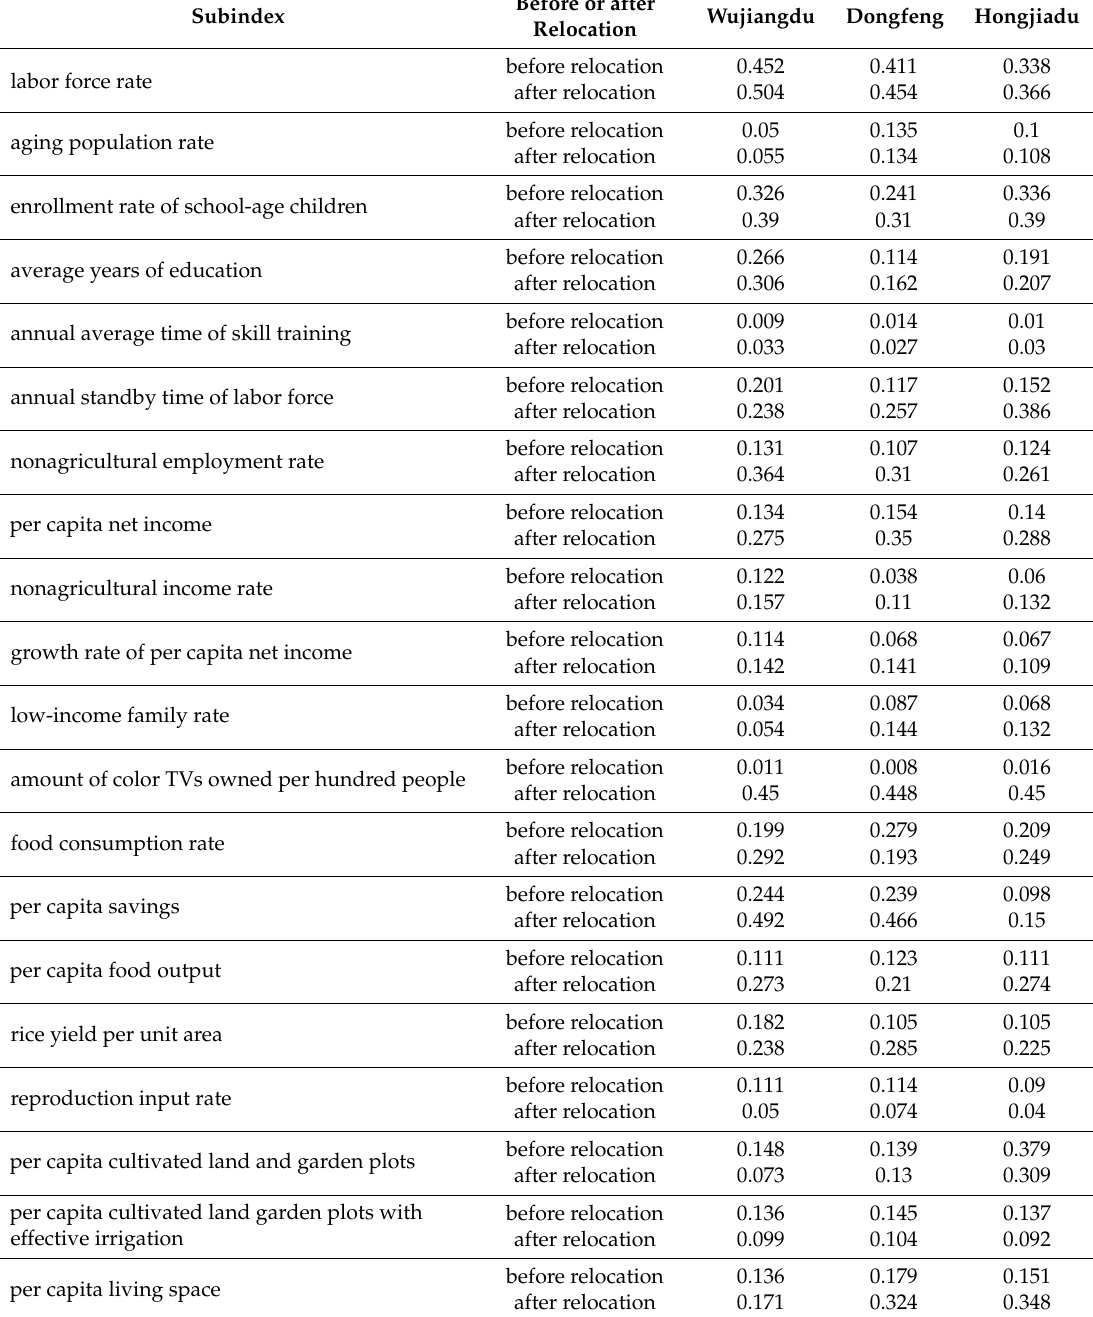
Table 2. Results of the comprehensive membership calculation of the Wujiangdu, Dongfeng, and Hongjiadu Power